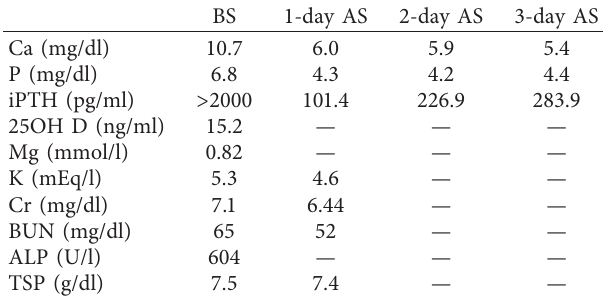
Table 1: Biochemical data at the time of diagnosis and after